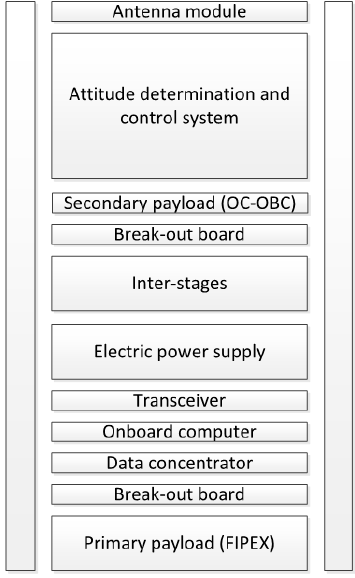
Figure 7. SE01 subsystem layout.